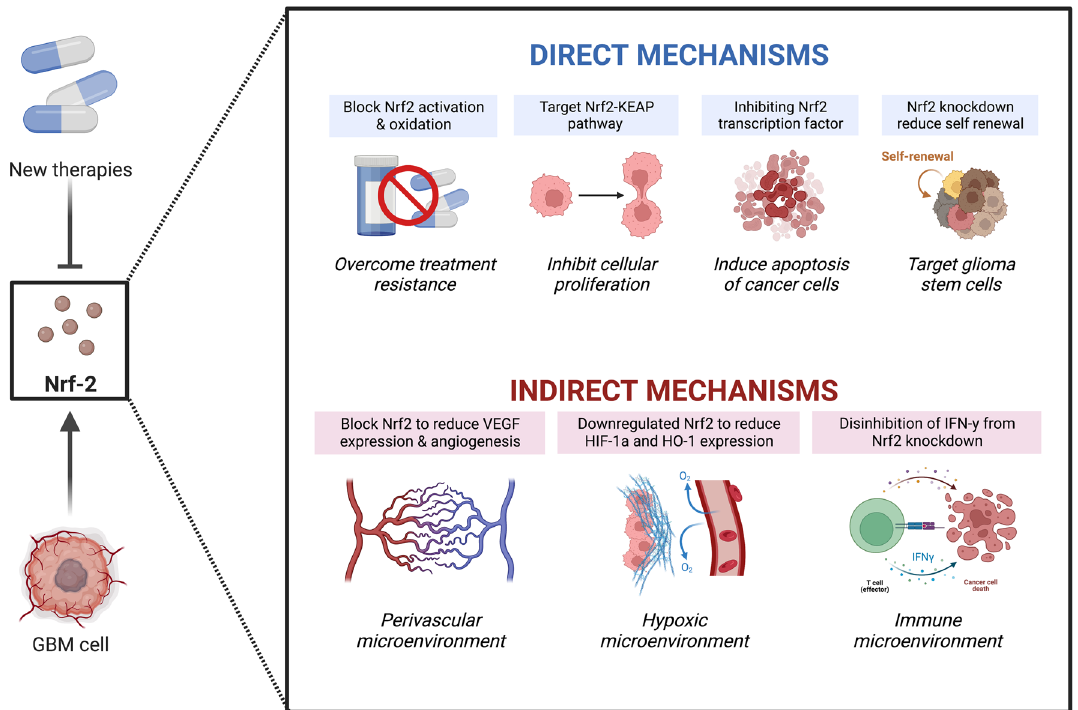
Fig. 3 Schematic showing potential targets for GBM therapy related to Nrf2 signaling and expression. (Created with